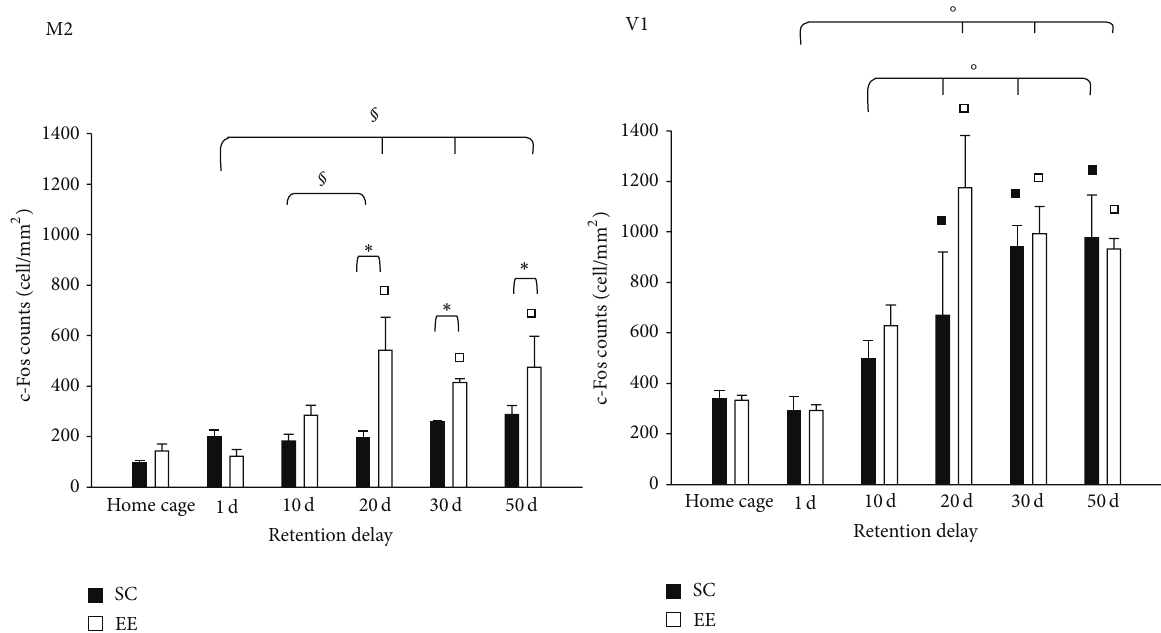
Figure 5: c-Fos protein expression in V1 and M2. M2 : two-way ANOVA post hoc analysis Holm-Sidak method, HC-SC versus HC-EE, 𝑃 = 0.416 ; statistical significance for EE versus HC-EE at 20, 30, and 50 days. Statistical difference between EE and SC at 1 day, 𝑃 = 0.288 ; at 10 days, 𝑃 = 0.154 ; at 20, 30, and 50 days, 𝑃 < 0.05 . Statistical differences within EE group were found between 10 and 20 days, and 1 day versus 20, 30, and 50 days, all 𝑃 values < 0.05. V1 : two-way ANOVA post hoc analysis Holm-Sidak method, HC-SC versus HC-EE 𝑃 = 0.907 ; statistical significance for EE versus HC-EE at 20, 30, and 50 days, and for SC versus HC-SC at 20, 30, and 50 days, all 𝑃 values < 0.05. Statistical significance for factor day was found between 1 day versus 20, 30, and 50 days, and 10 days versus 20, 30, and 50 days, all 𝑃 values < 0.05. ◼ Statistical significance between EE and HC-EE; ◻ statistical significance between SC and HC-SC; ∗ = statistical significance between EE and SC; ∘ statistical significance for factor day § = statistical significance within EE group; error bars = s.e.m.